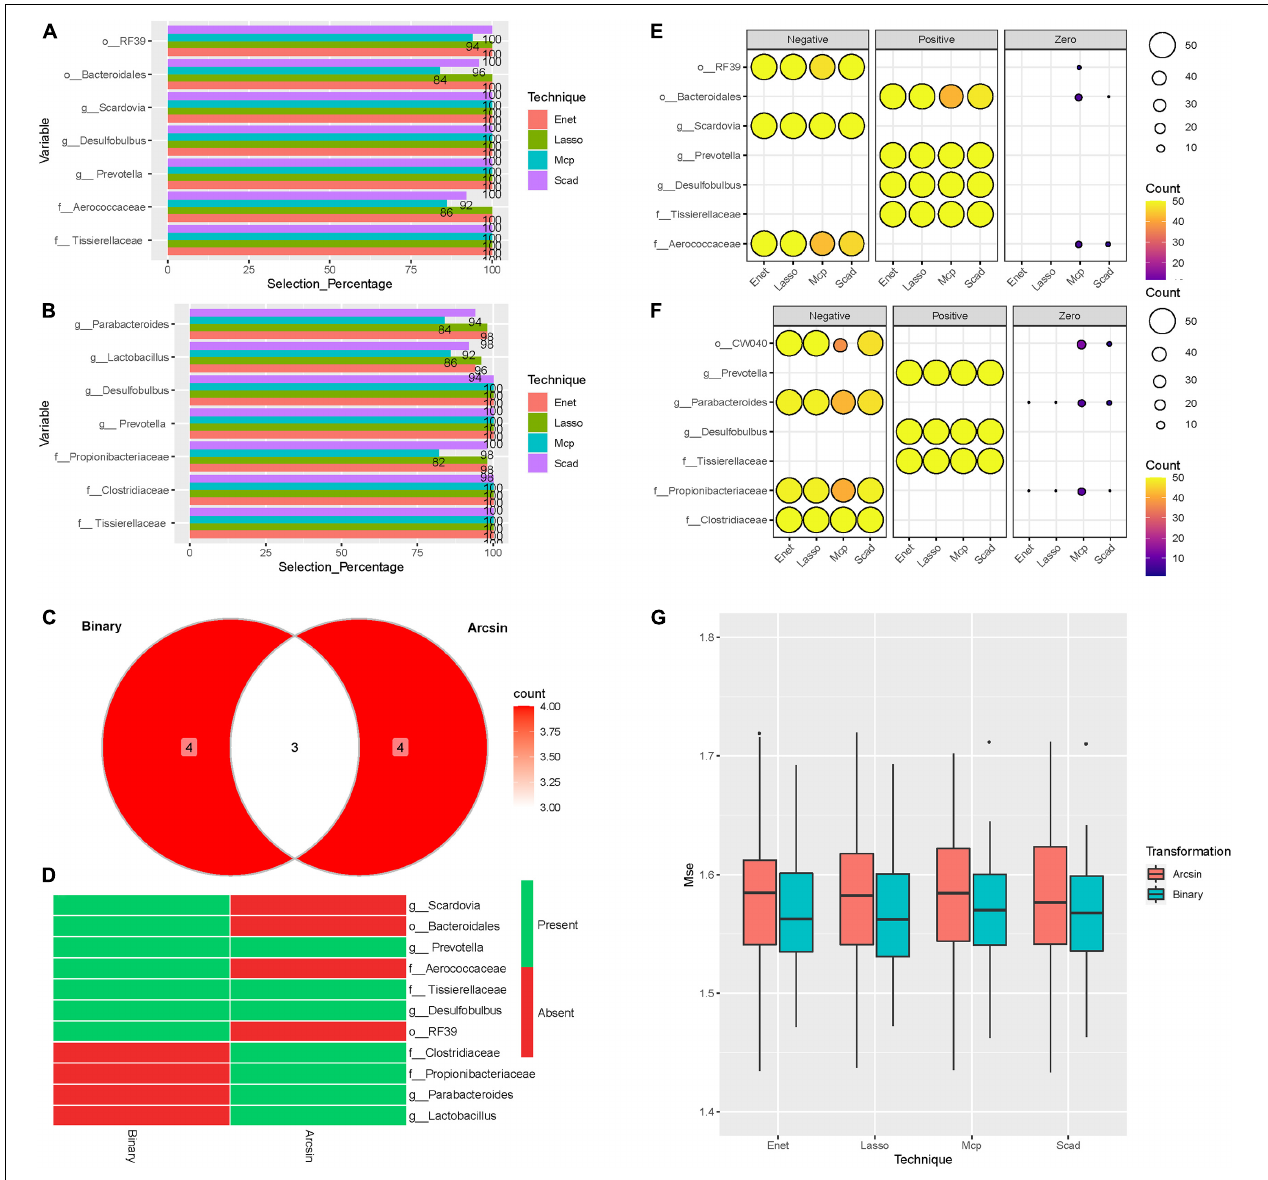
FIGURE 4 | Machine learning models. Barplots representing the selection percentages of the microbes selected at least 80% of the time by the four methods over the 50 random splits of the data. (A) Binary transformation. (B) Arcsin transformation. (C) Venn Diagram showing the number of microbes. (D) Heatmap [presence (green)/absence (red)] of selected microbes using Binary and Arcsin transformations. (E) Balloon plot representing sign counts of the regression coefficients: Binary transformation (F) Arcsin transformation. The size of circles represents the number of splits. The color represents the number of counts. (G) Box plots of the MSE for the four-methods and the two transformations applied to the microbiome abundance data. Each point of the boxplot represents the MSE on the